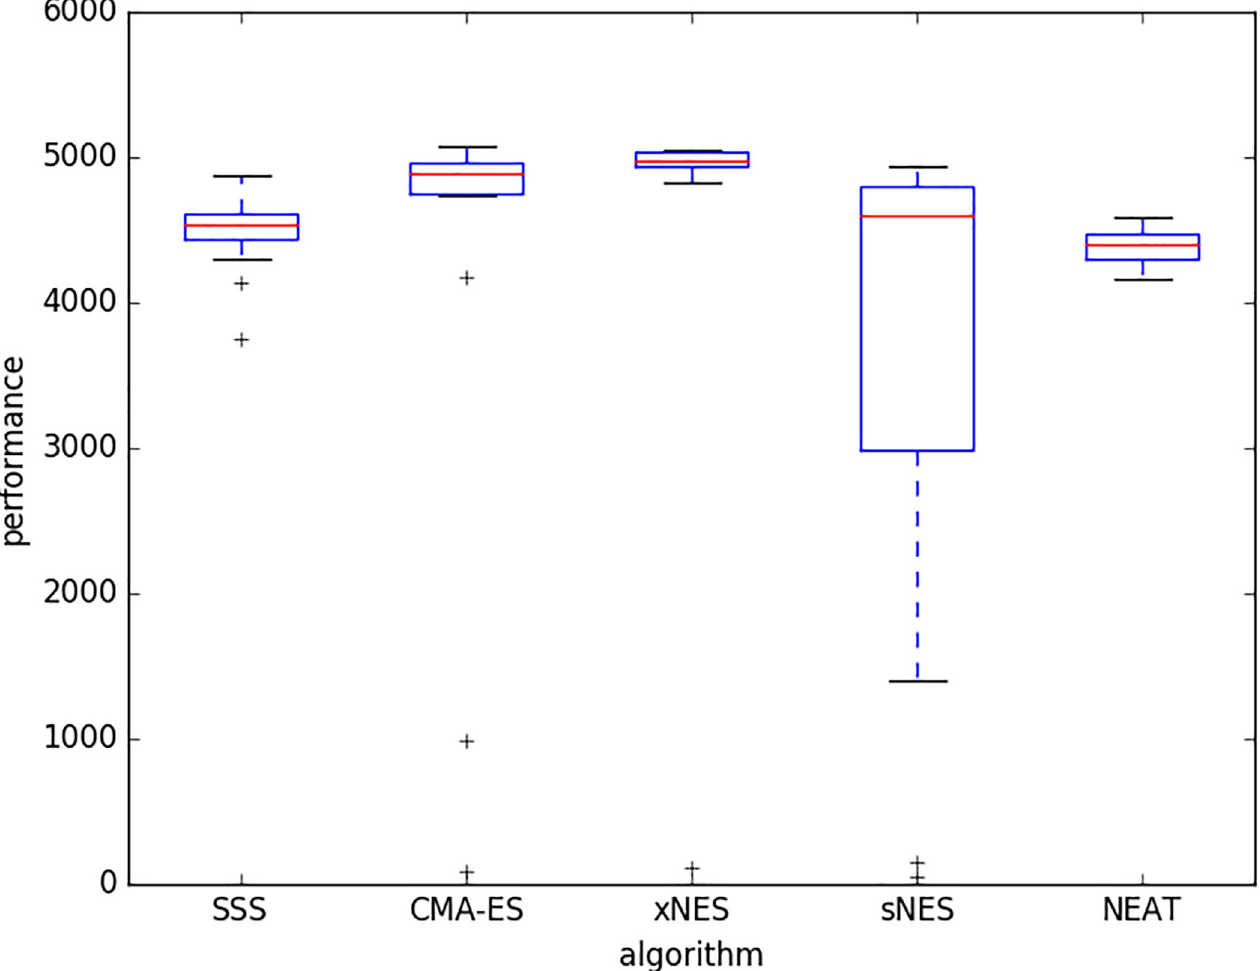
Fig 9. Performance of the best candidate solutions post-evaluated for 25 trials. Each experiment has been replicated 20 times. Boxes represent the inter- quartile range of the data and horizontal lines inside the boxes mark the median values. The whiskers extend to the most extreme data points within 1.5 times the inter-quartile range from the box. “+” indicate the outliers.